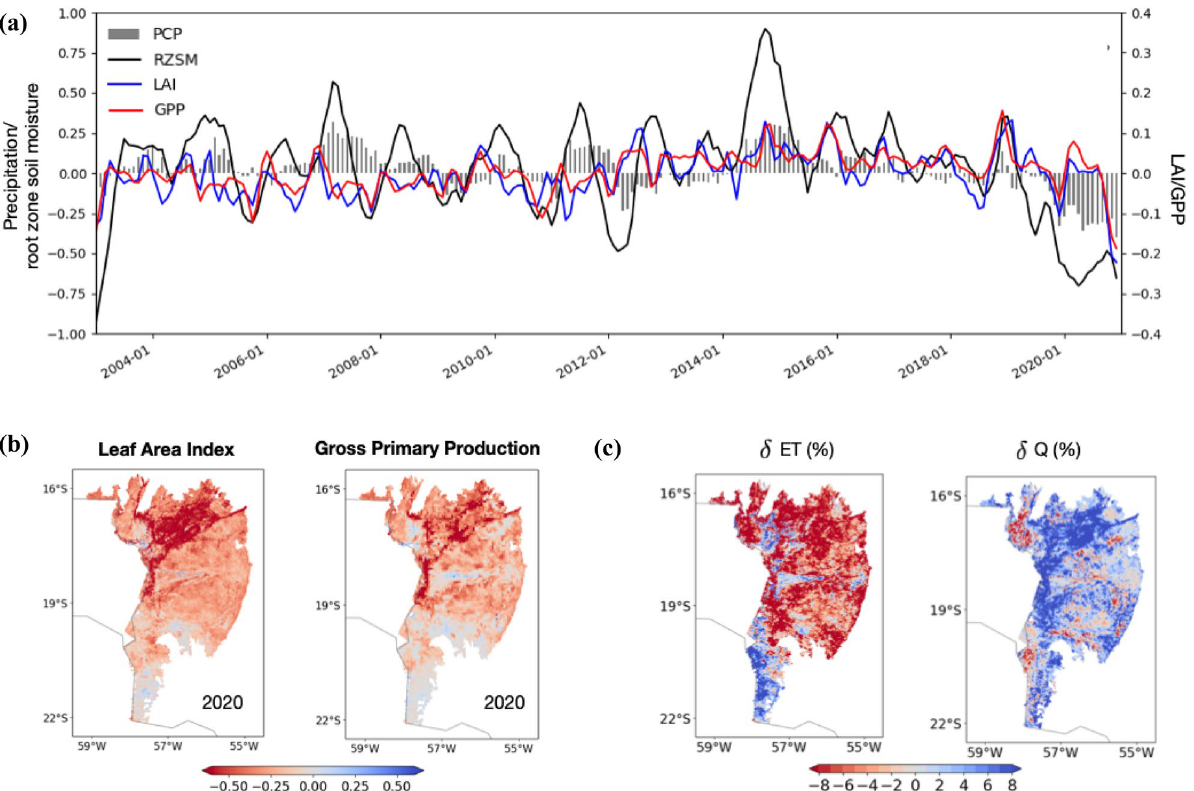
Figure 3. Time series (Panel a) of domain averaged standardized anomalies of 12-month precipitation, 6-month root zone soil moisture (RZSM), 2-month Leaf Area Index (LAI), and 2-month Gross Primary Production (GPP). The bottom panel b shows the ecosystem impacts of the 2020 fire events, with spatial maps of standardized anomalies in 2-month LAI, and 2-month GPP, averaged during Sep-Nov for 2020. Panel c shows impacts of fires on the local hydrology over the Pantanal. The percentage change in evapotranspiration (ET) and runoff (Q) during the post-fire time period, relative to a scenario where climatological average vegetation conditions are present. The spatial maps in Panels b and c are created using matplotlib (https:// matpl otlib. org/). LAI (standardized anomaly, % of area below – 1.5